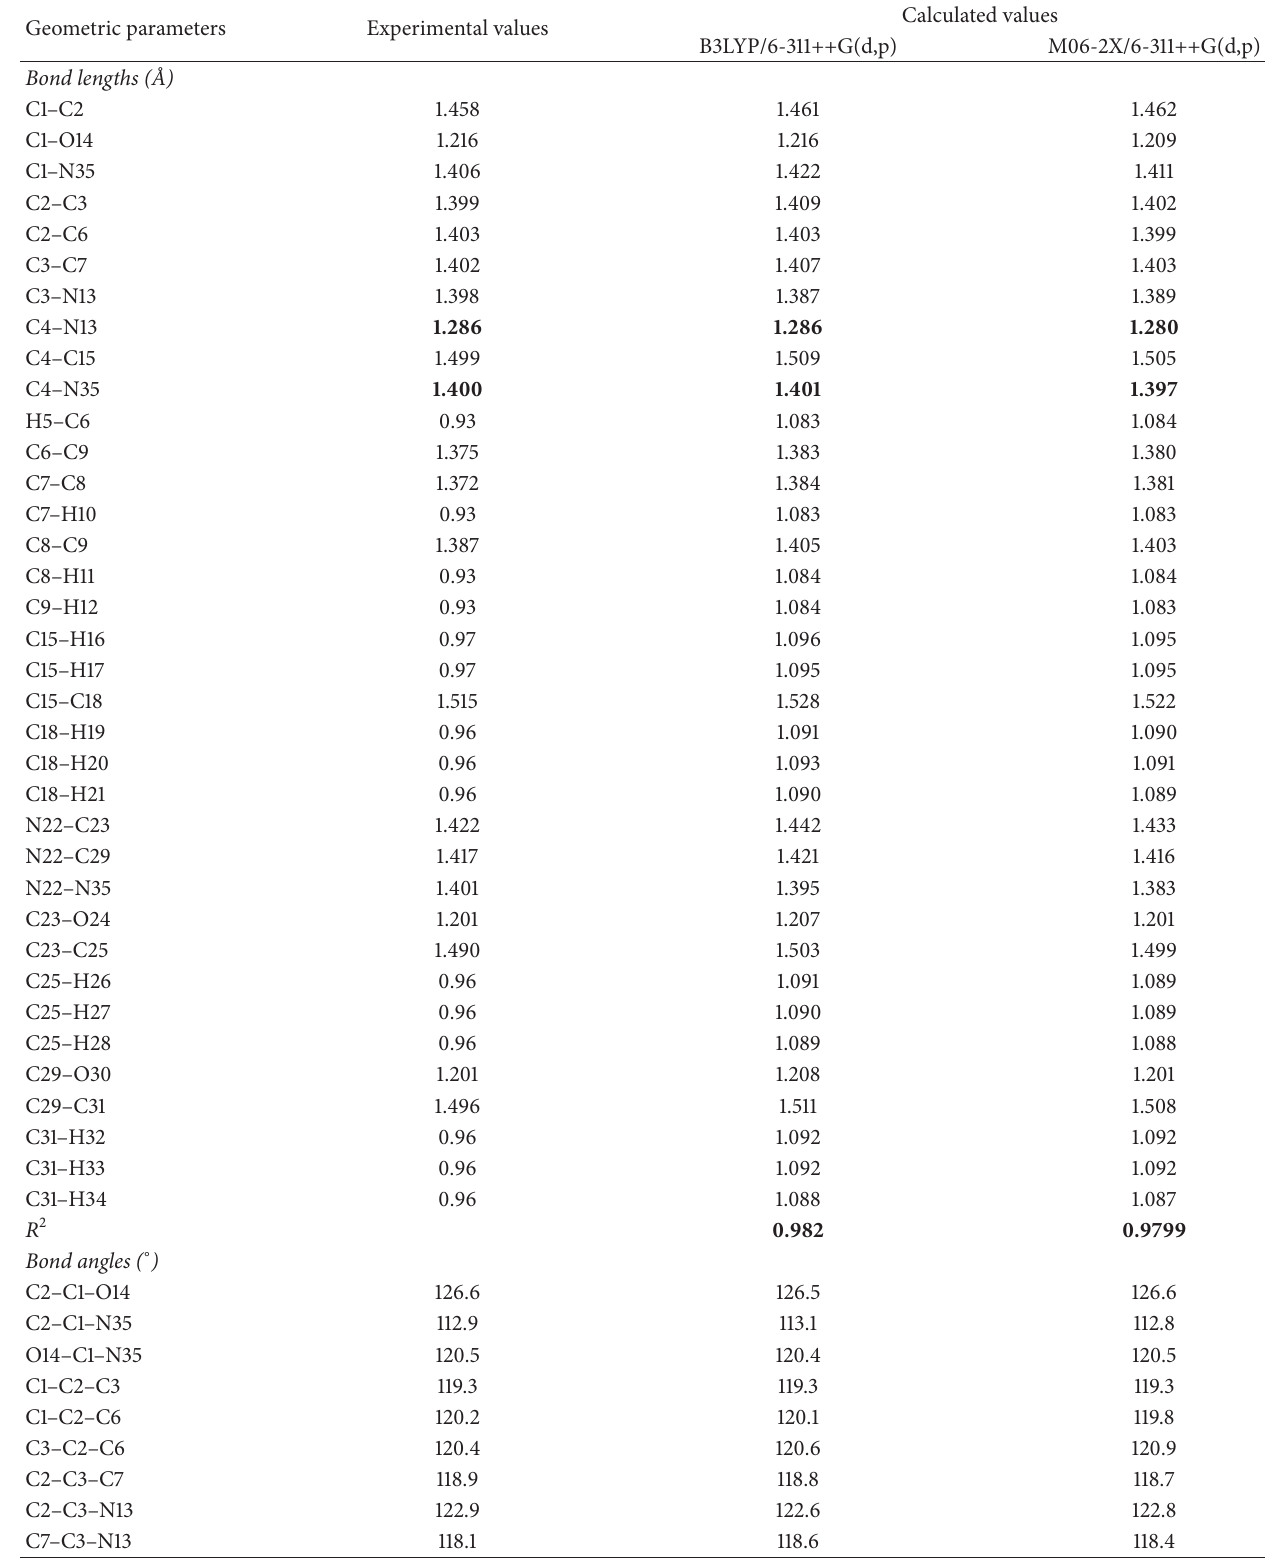
Table 1: Experimental and calculated geometric parameters of compound 2 (figures in bold relate to parameters discussed in the text). Geometric